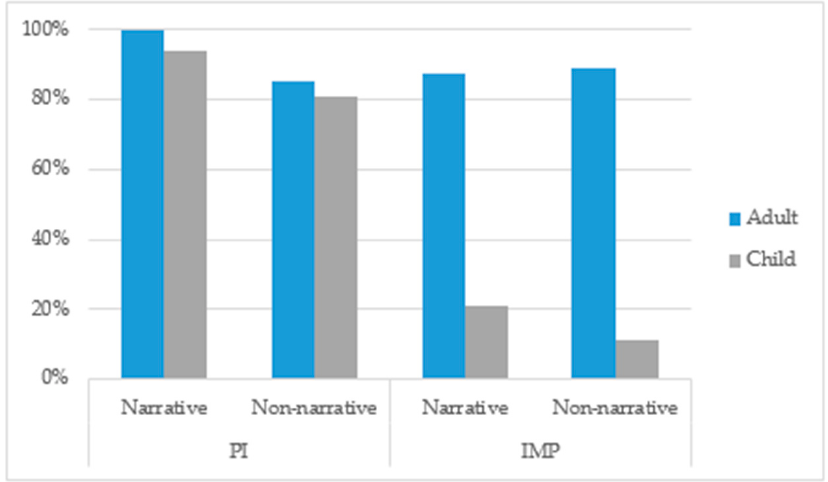
Figure 6. Proportion of target responses per age group and experimental setting for the C–I condition.